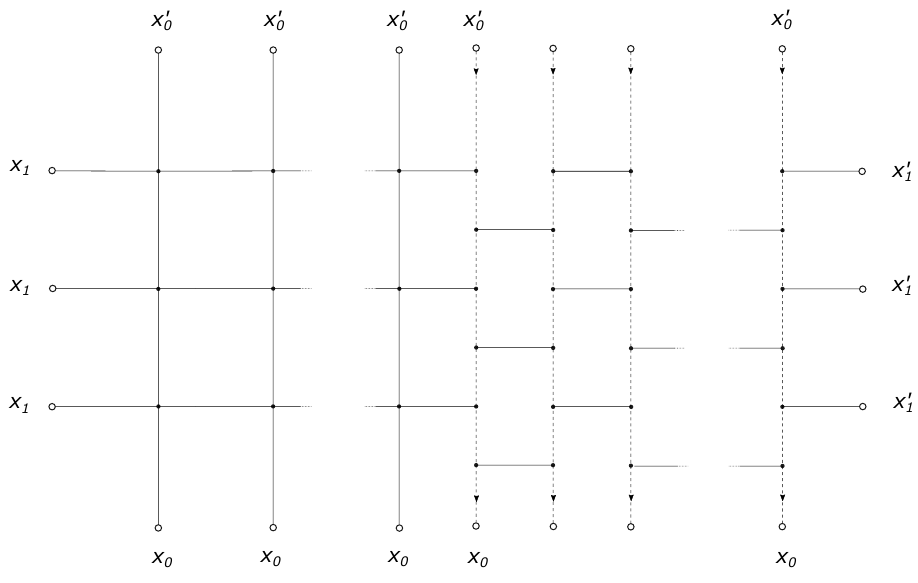
) for a size of the square , x 0 0 1 + L ) with N = 3 horizontal and L + L vertical solid lines, and a Yukawa 1 2 1 2 + M ) , where M + M is the number of fermionic (dashed) vertical lines 1 2 1 2 insertions of ψ 1 insertions of ¯ ψ ( x 0 ) ¯ ψ ( x ) . Every dashed segment along a line is alternatively 2 3 3 0 0